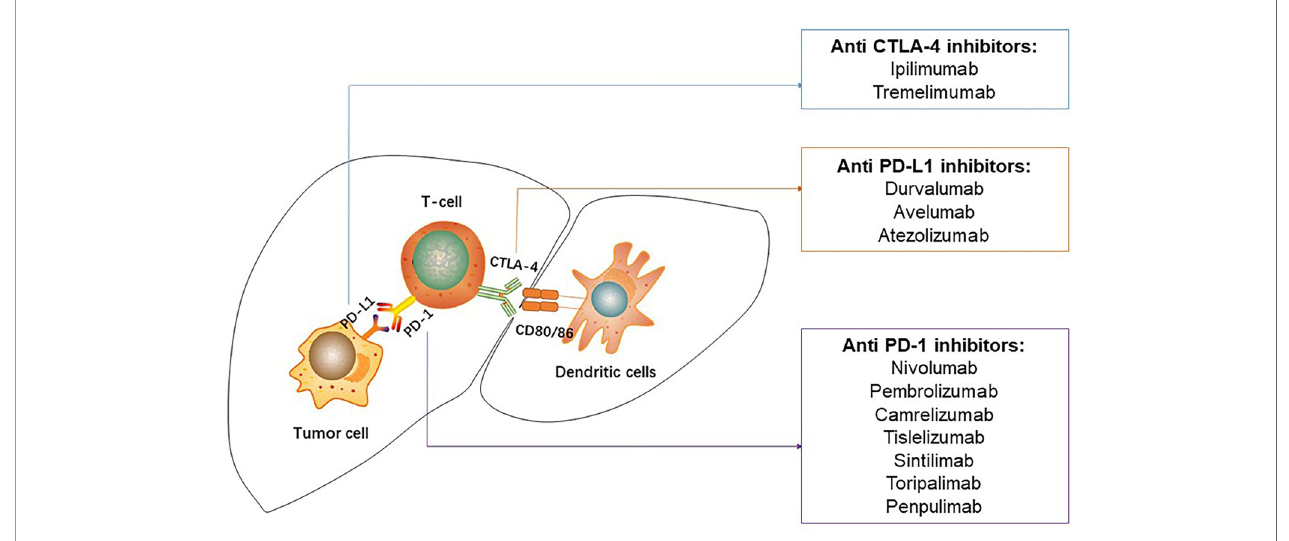
FIGURE 2 | Immune checkpoint inhibitors used in hepatocellular carcinoma. PD-1, programmed death-1; PD-L1, programmed death-ligand 1; CTLA-4, cytotoxic T- lymphocyte associated protein-4.